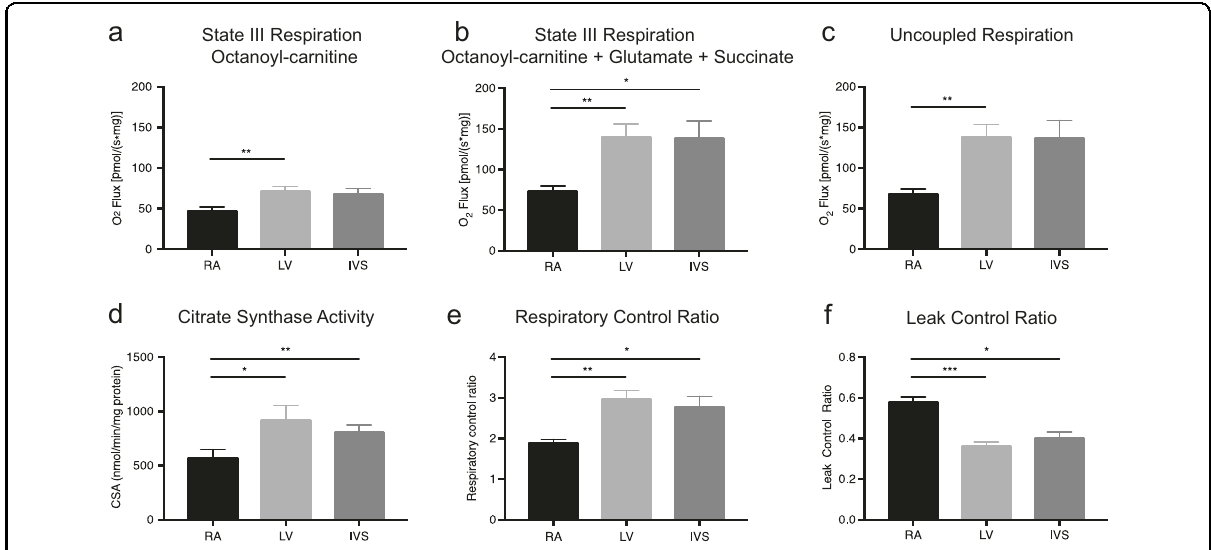
Fig. 2 Comparison of myocardial right atrial, left ventricular, and IVS tissue specimens obtained from heart explants. a State III mitochondrial respiration on the medium-chain fatty acid octanoyl-carnitine. b State III mitochondrial respiration on octanoyl-carnitine and the citrate cycle-derived substrates glutamate and succinate. c Uncoupled mitochondrial respiration after addition of the uncoupling factor fccp (carbonyl cyanide- 4 -(tri fl uoromethoxy)phenylhydrazone). d Citrate synthase activity per milligram protein as a marker of mitochondrial content. e Respiratory control ratio as a marker of increased mitochondrial coupling ef fi ciency. f Leak control ratio as a marker of impaired mitochondrial coupling ef fi ciency. A atrium, CSA citrate synthase activity, IVS interventricular septum, L left, R right, V ventricle. Data are the means ± SEM ( n = 9 – 11/ group). Multiple paired t -test with Bonferroni correction. * p < 0.05; ** p < 0.01